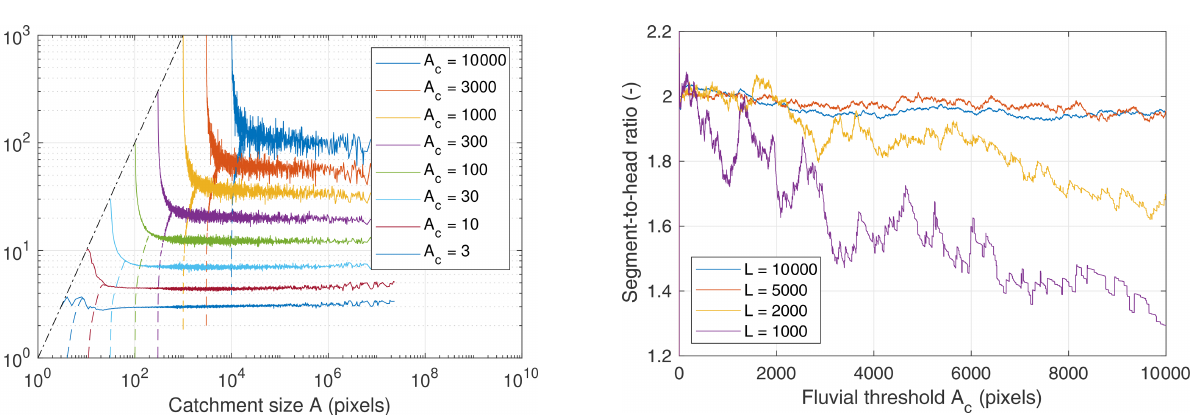
Figure 5. Eroded area A e as a function of the catchment size A for different fluvial thresholds A c . Raw data were used for the catch- ment sizes that occurred at least 1000 times on the grid. Otherwise, data were binned dynamically so that there are at least 1000 points in each bin.